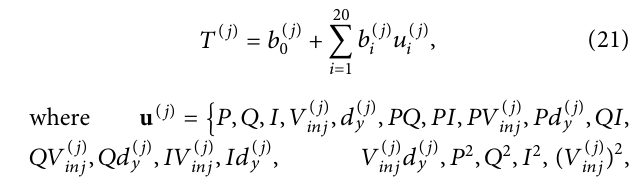
Figure 3: Schematic of the proposed robust adaptive control scheme for an APSP; ( C ( 1 ) the NiCrAlY and the ZrO 2 particles, respectively; v � the mean axial velocity of both particles; T � the mean temperature of both particles; , V ( 2 ) � the average injection velocity of NiCrAlY and ZrO V ( 1 ) inj inj injectors,